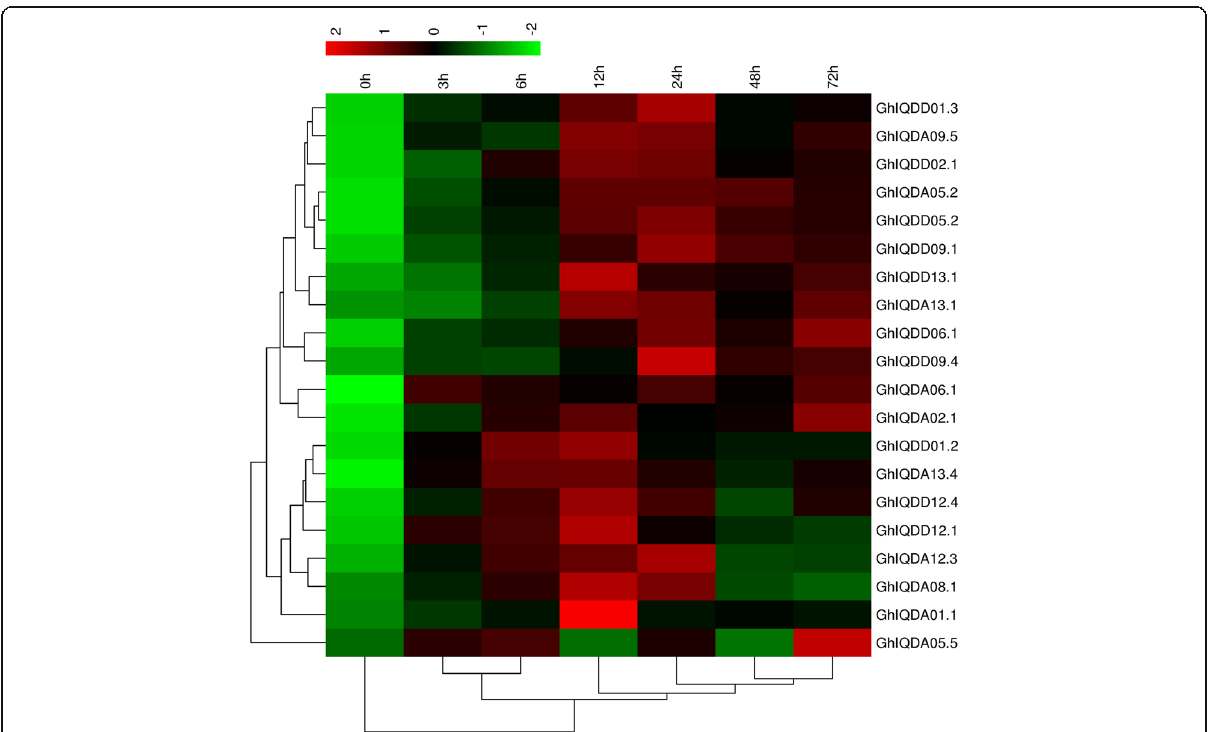
Fig. 6 The expression profiles of 20 selected GhIQD genes in response to MeJA treatment at 0, 3, 6, 12, 24, 48, and 72 h. The gene expression values were determined by qRT-PCR and calculated using the 2 - △△ C T method. The online software Omicshare (https://www.omicshare.com/tools/ Home/Soft/heatmap) was used to normalize the expression values and draw the heatmap. The color scale on the top of the figure represents expression values computed by the 2 - ΔΔ C T